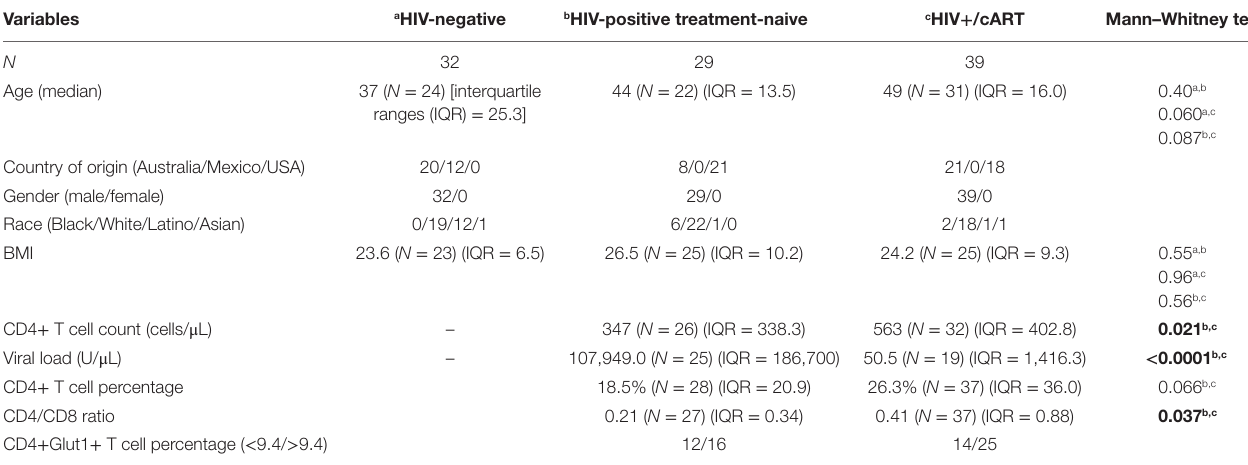
TaBle 1 | Clinical characteristics of study population.